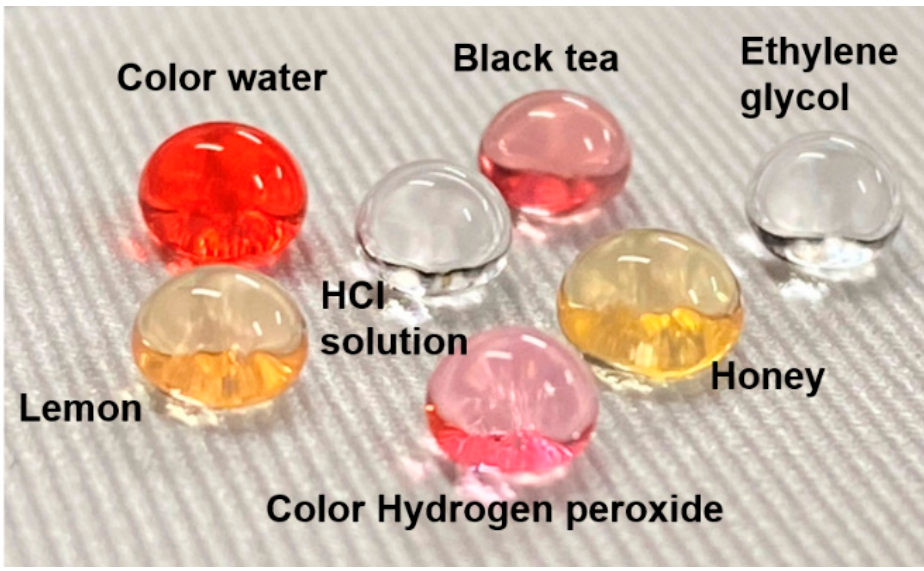
Figure 2. Optical image of PET-PDMS@ZnO fabric consisting of various